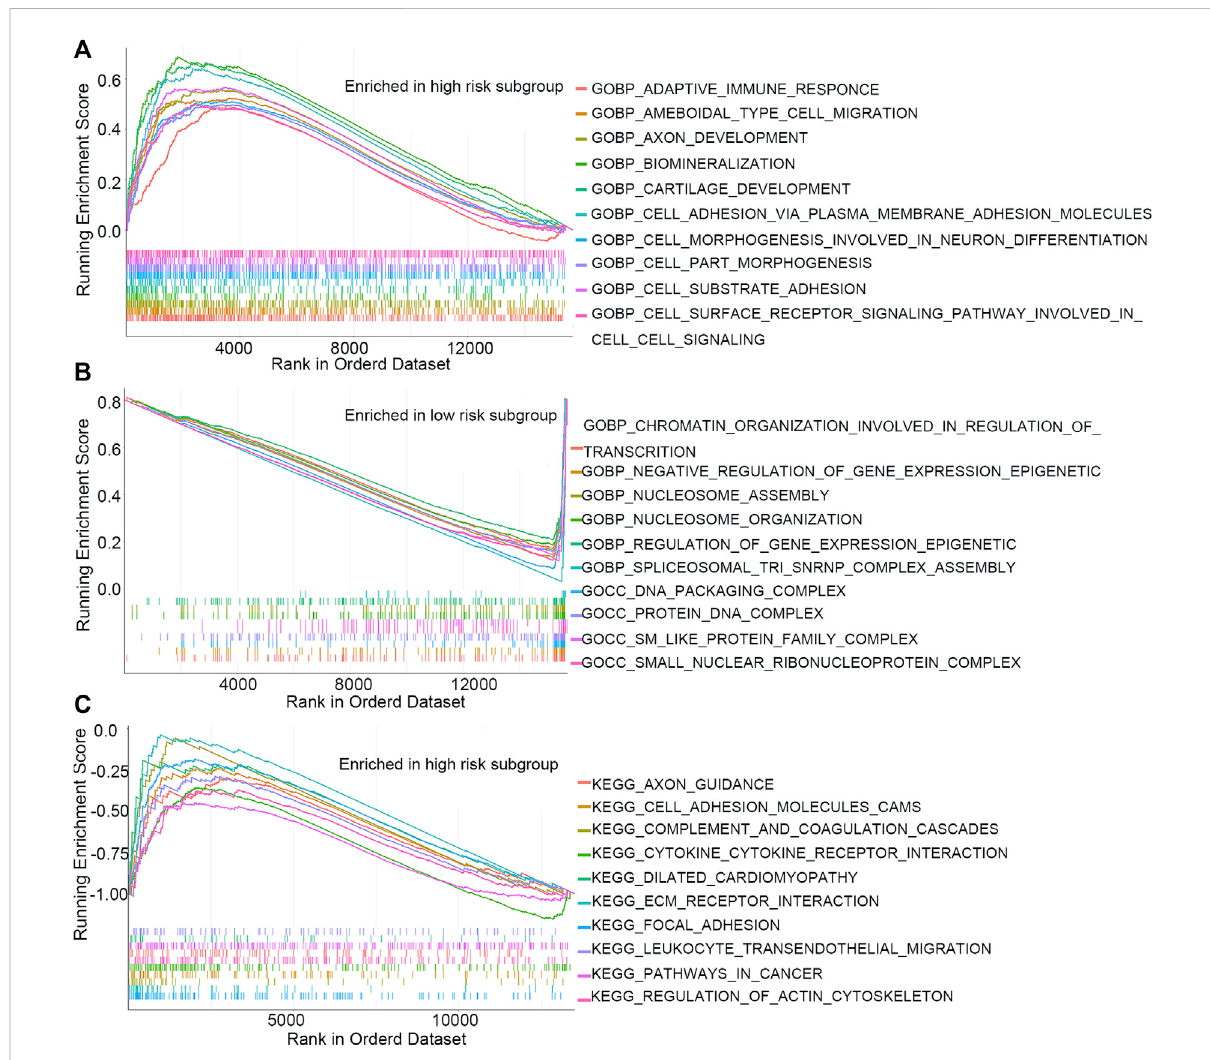
FIGURE 7 GSEAanalysis. (A) Top10GOitemsinthehigh-risksubgroup. (B) Top10GOitems inthelow-risk subgroup. (C) Top10KEGGitems inthehigh- risk